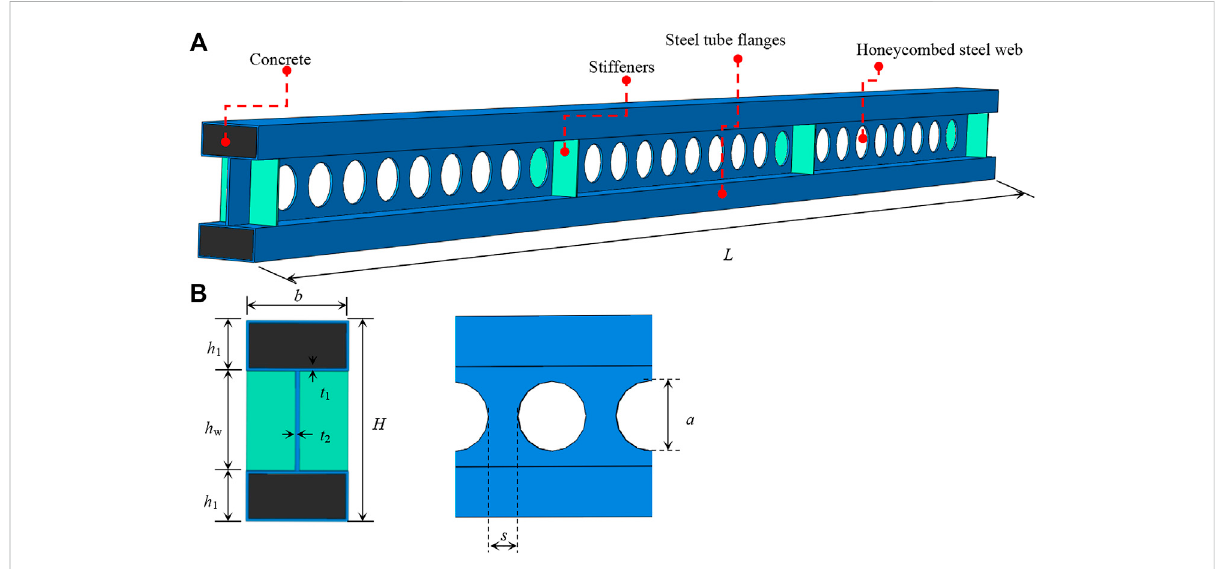
FIGURE 1 SHC and the local dimensions. (A) The composition of SHC (B) The sectional size of SHC and steel web.